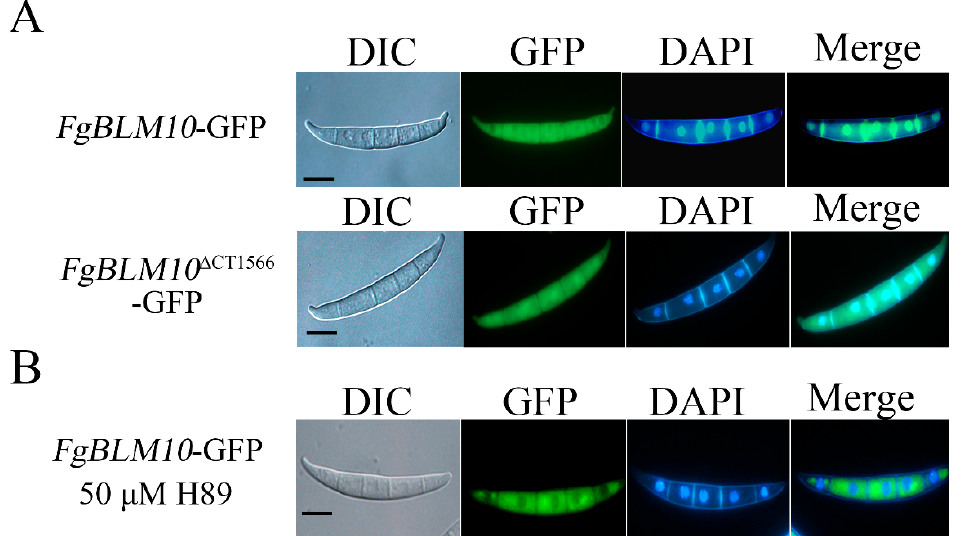
Figure 8. Subcellular localization of FgBLM10 -GFP and FgBLM10 ∆ CT1566 -GFP fusion proteins. ( A ) Conidia of the FgBLM10 -GFP transformant were examined by differential interference contrast (DIC) and epifluorescence microscopy. Green fluorescent protein (GFP) signals were observed in the nucleus and cytoplasm of conidia. Bar = 10 µm. Nuclei were stained with DAPI (4 ′ ,6-diamidino-2- phenylindole). ( B ) Conidia of the FgBLM10 -GFP transformant treated with 50 µ M H89 were examined by differential interference contrast (DIC) and epifluorescence microscopy. Green fluorescent protein (GFP) signals were observed in the nucleus and cytoplasm of conidia. Bar = 10 µ